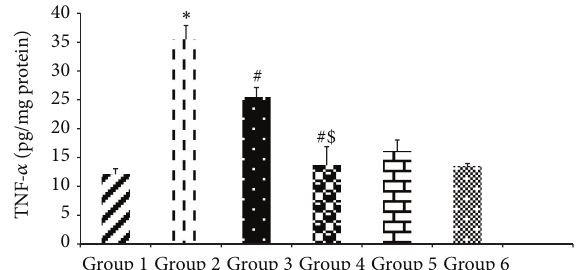
Figure 8: Effect of probiotics on hepatic TNF- 𝛼 levels in alcohol- fed rats. Values are expressed as mean ± S.D. of eight different observations. ∗ 𝑃 < 0.05 versus group 1, group 5, and group 6; # 𝑃 < 0.05 versus alcohol (Alc) (group 2); $ 𝑃 < 0.05 versus group 3.